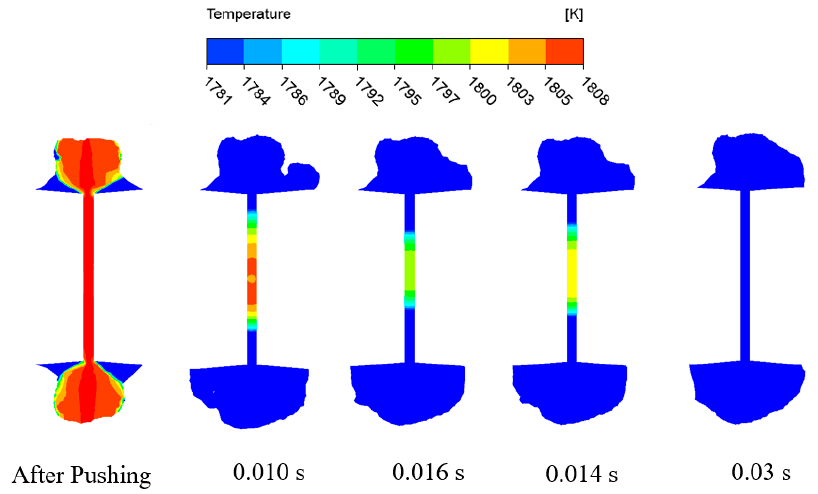
Figure 7. Solidification contour of welded joint after upsetting process.